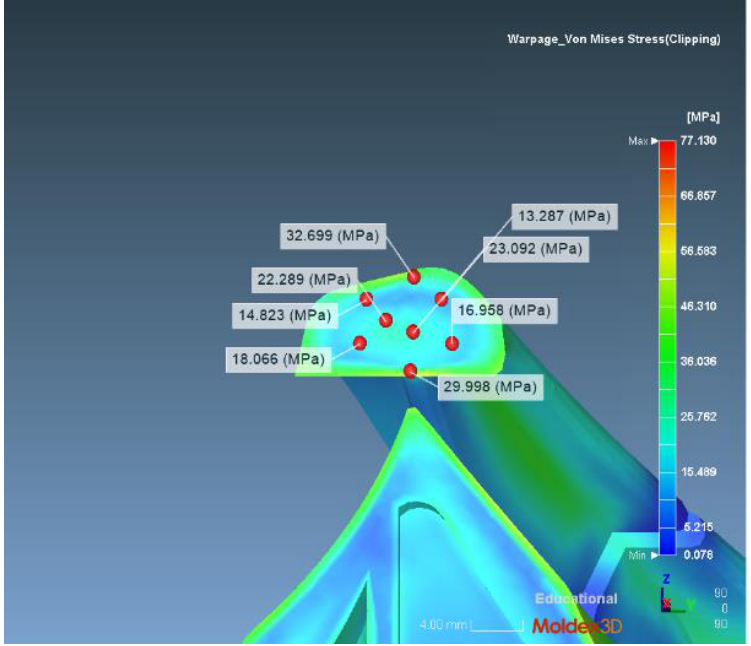
Figure 4. Distribution of the 0.46 radius theoretical stress concentration factor. The theoretical cross-section stress refers to the average normal stress obtained by dividing the axial load on the specimen by the net cross-sectional area of the notch. The cross-section is irregular, and its area cannot be obtained by direct calculation. Using SolidWorks’ function of evaluating section properties, the area of the cross-section is measured. The test result is shown in Figure 5. The cross-sectional area of the theoretical stress of the cross-section is 108.13 mm 2 , the axial load is preset to 234.973 N, and the theoretical stress is obtained as 2.173 N/mm 2 , which is converted into 2.173 MPa. Therefore, the value of the theoretical stress concentration factor K t is 9.989. The size of the axial load is preset to 221.546 N, and the theoretical stress is obtained as 2.049 N/mm 2 , which is converted to 2.049 MPa. Therefore, the value of the theoretical stress concentration factor K t is